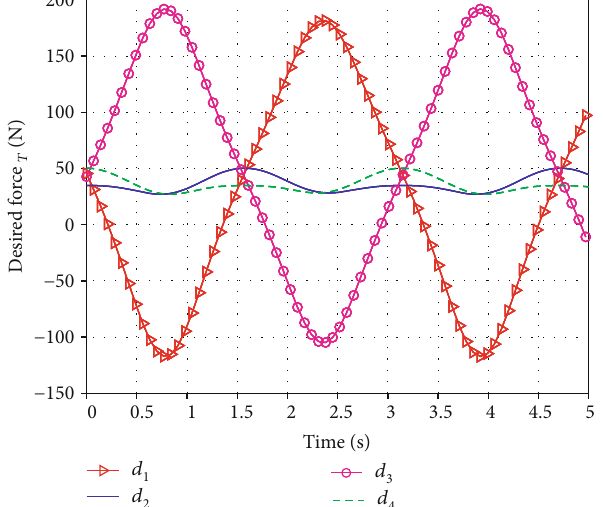
Figure 15: The trajectory tracking comparison in the z direction.